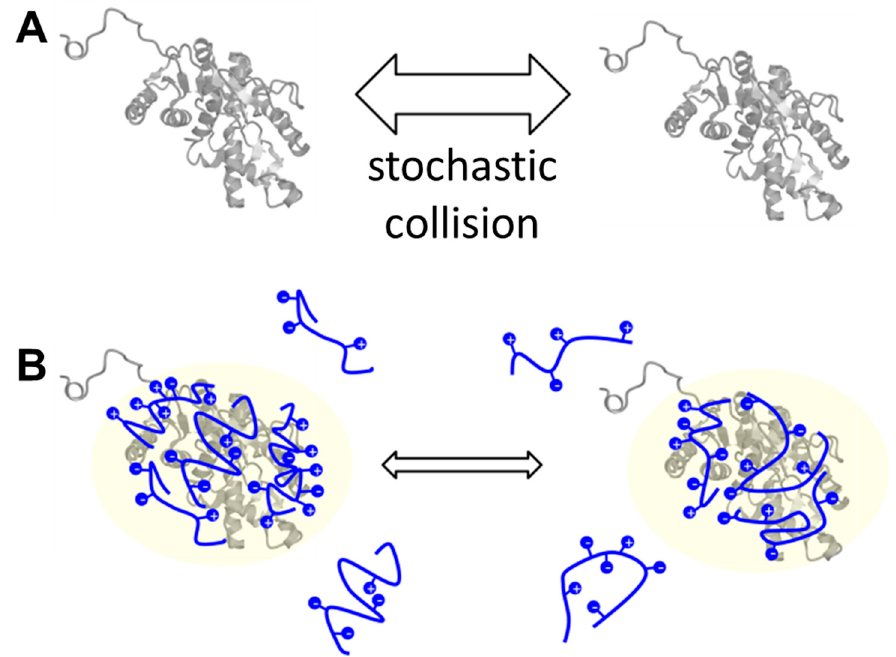
Figure 6. Schematic representation of the cryoprotective/lyophilization protective action of IDPs. The common mechanism of cryoprotection and lyophilization protection is based on the model of molecular shield function proposed by Chakrabortee et al. (see text) [48]. The LDH molecule is represented by the gray ribbon diagram of a protein (representation). Protectants with positive and negative charges are represented as strings. Thick and thin arrows indicate higher and lower rates of direct collision between two enzyme molecules, respectively. ( A ) In the absence of additive protectant molecules, the two enzyme molecules have a certain rate of encounter; ( B ) In the presence of protectants, the stochastic collision rate is decreased, thereby reducing aggregation.